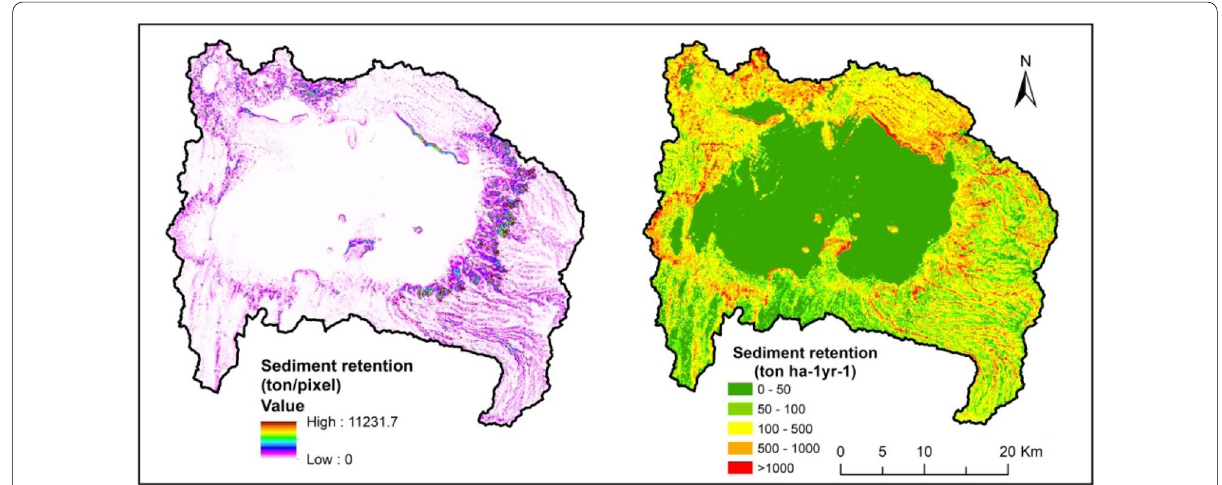
Fig. 5 Sediment retention rate in the Lake Hawassa